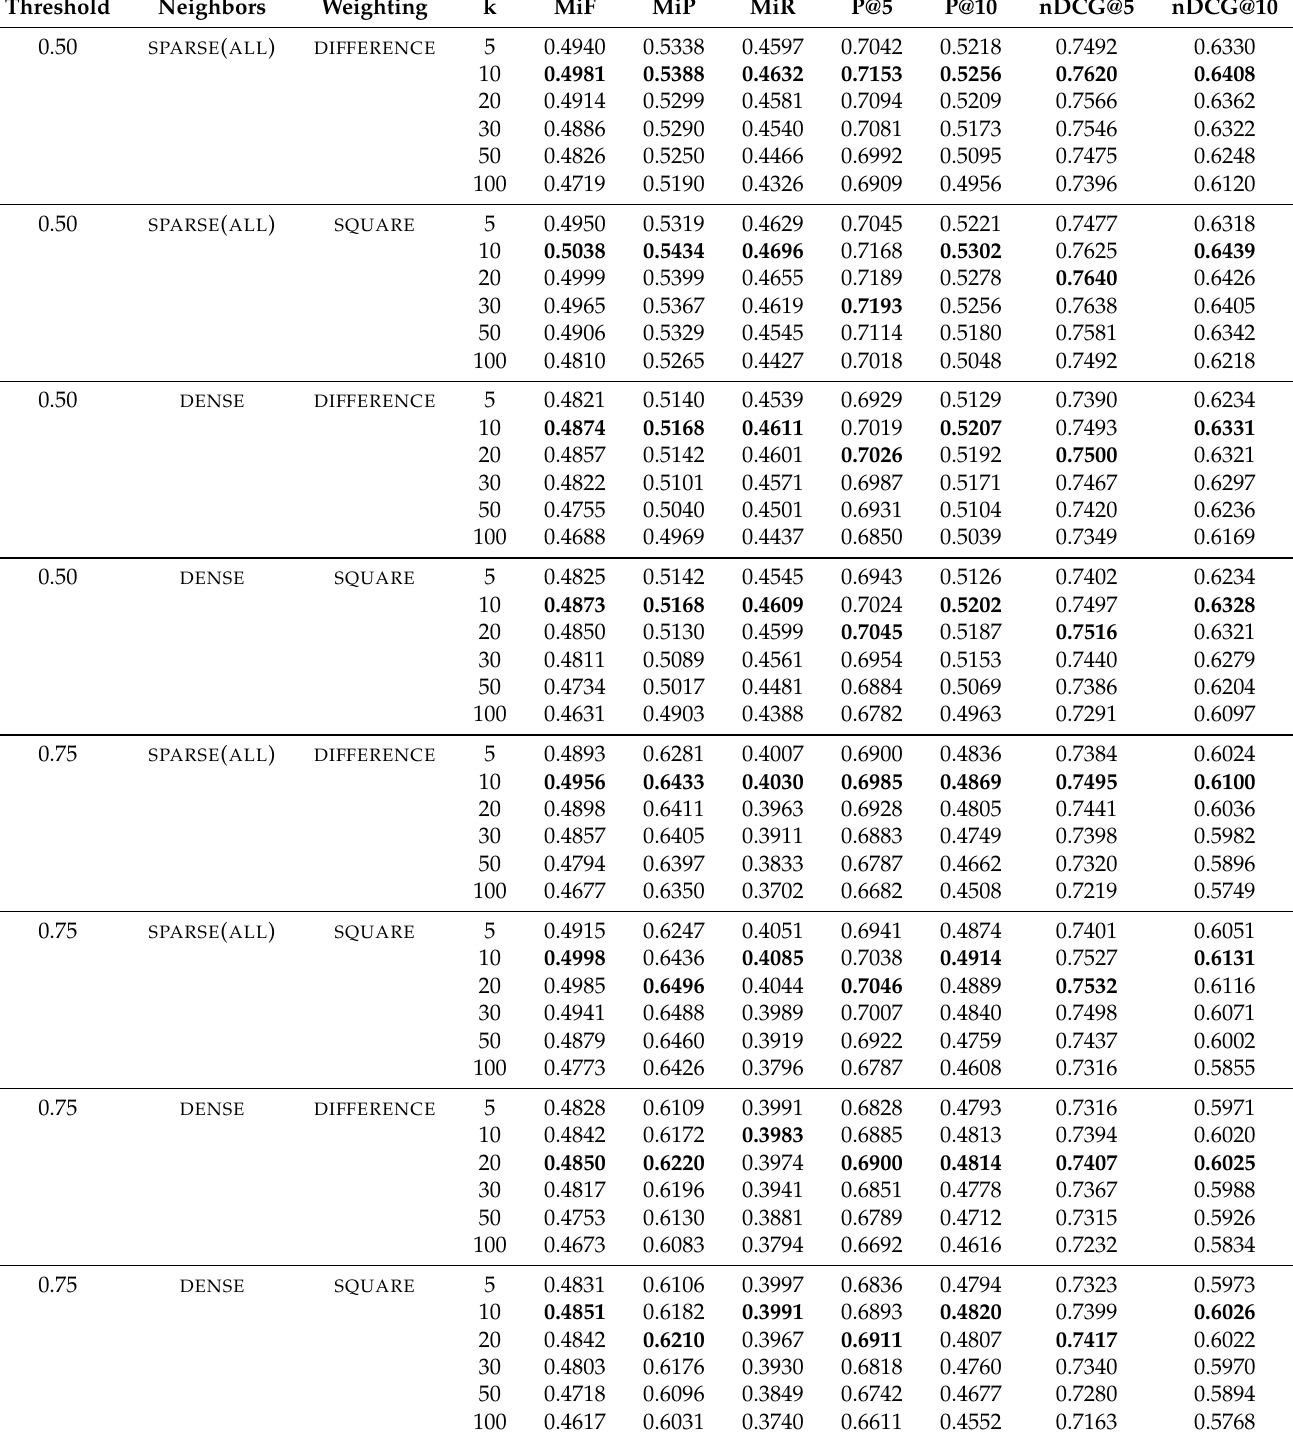
Table 5. Performance with SMALL label-AE